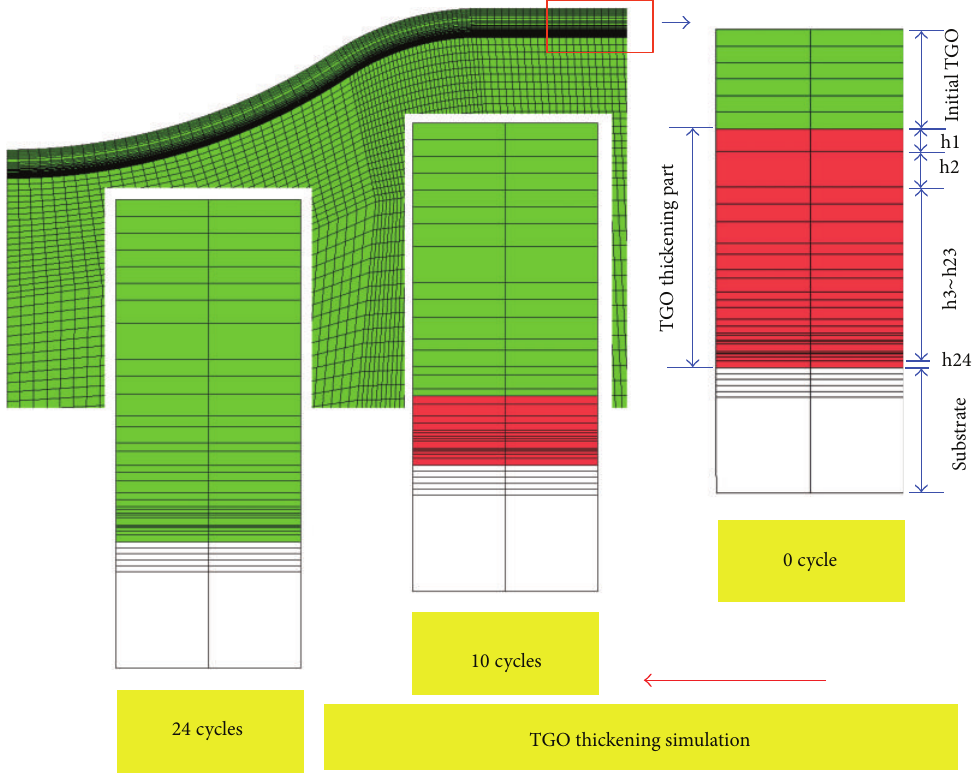
Figure 5: The sketch illustrating the TGO increasingly formed upon twenty-four thermal